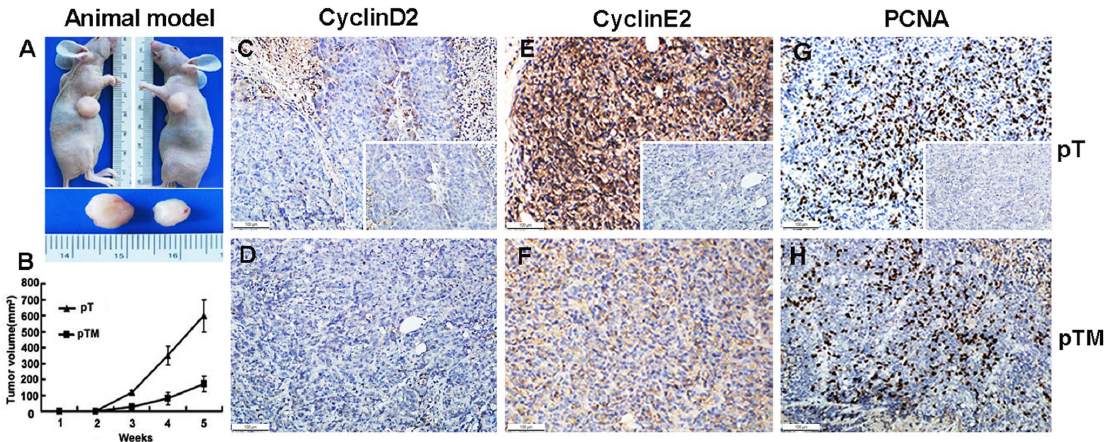
Figure 5. Ectopic expression of miR-26a inhibits pancreatic cancer growth in nude mice. (A) Nude mice were subcutaneously inoculated with SW-1990 cells transfected with pTM (pTM: hTERT–miR-26a plasmid) or pT (pT: hTERT control plasmid), in their flanks. The image is representative of tumors formed in 8 mice. (B) Growth curves of tumor volumes. The graph is representative of tumor growth, 5 weeks after inoculation. Tumor volume was calculated and all data are shown as the mean 6 S.D. ( n =8). (C–H) Expression of cyclin D2, cyclin E2, and PCNA was measured by immunohistochemistry in the tissues of mice inoculated with pTM- transfected SW-1990 cells or the control cells. The figure insets in C, E, and G indicate a negative control field. Cells colored brown indicate positive staining. Original magnification, 200 6